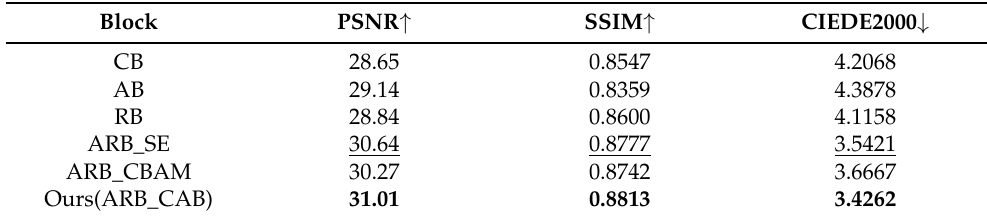
Table 4. Ablution analysis of the structure of ARB. The bold and underlined text indicates the best and second-best performance, respectively. The ↑ symbol indicates that larger values are better, while ↓ indicates that smaller values are better.